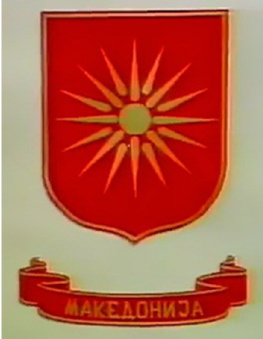
Figure 3. Todor Petrov’s proposal accepted by the Commission (July 1992).